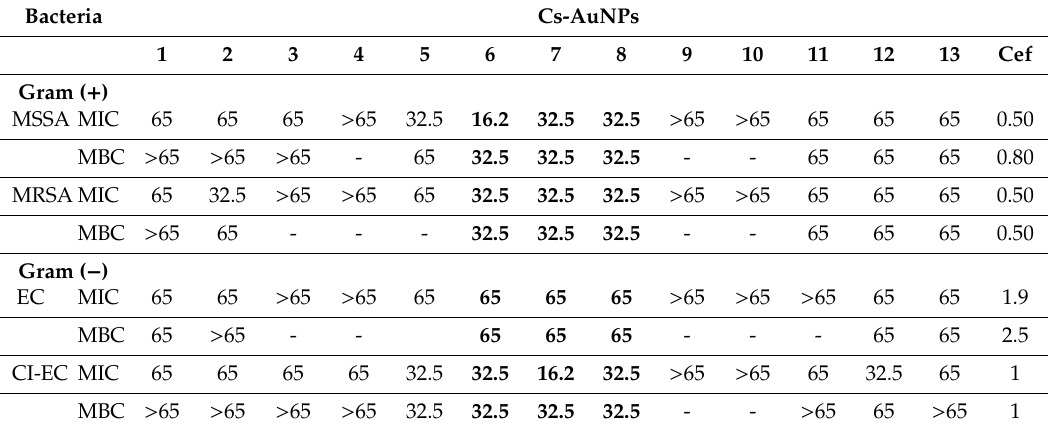
Table 5. Antibacterial activity of the synthesized Cs-AuNPs. Tests were made in triplicate and MIC values are expressed as µ g /